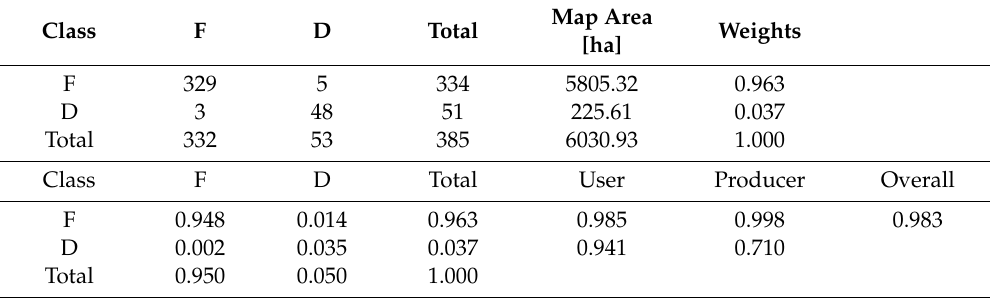
Table A8. “Union” Peru disturbance method validation (only forest area).